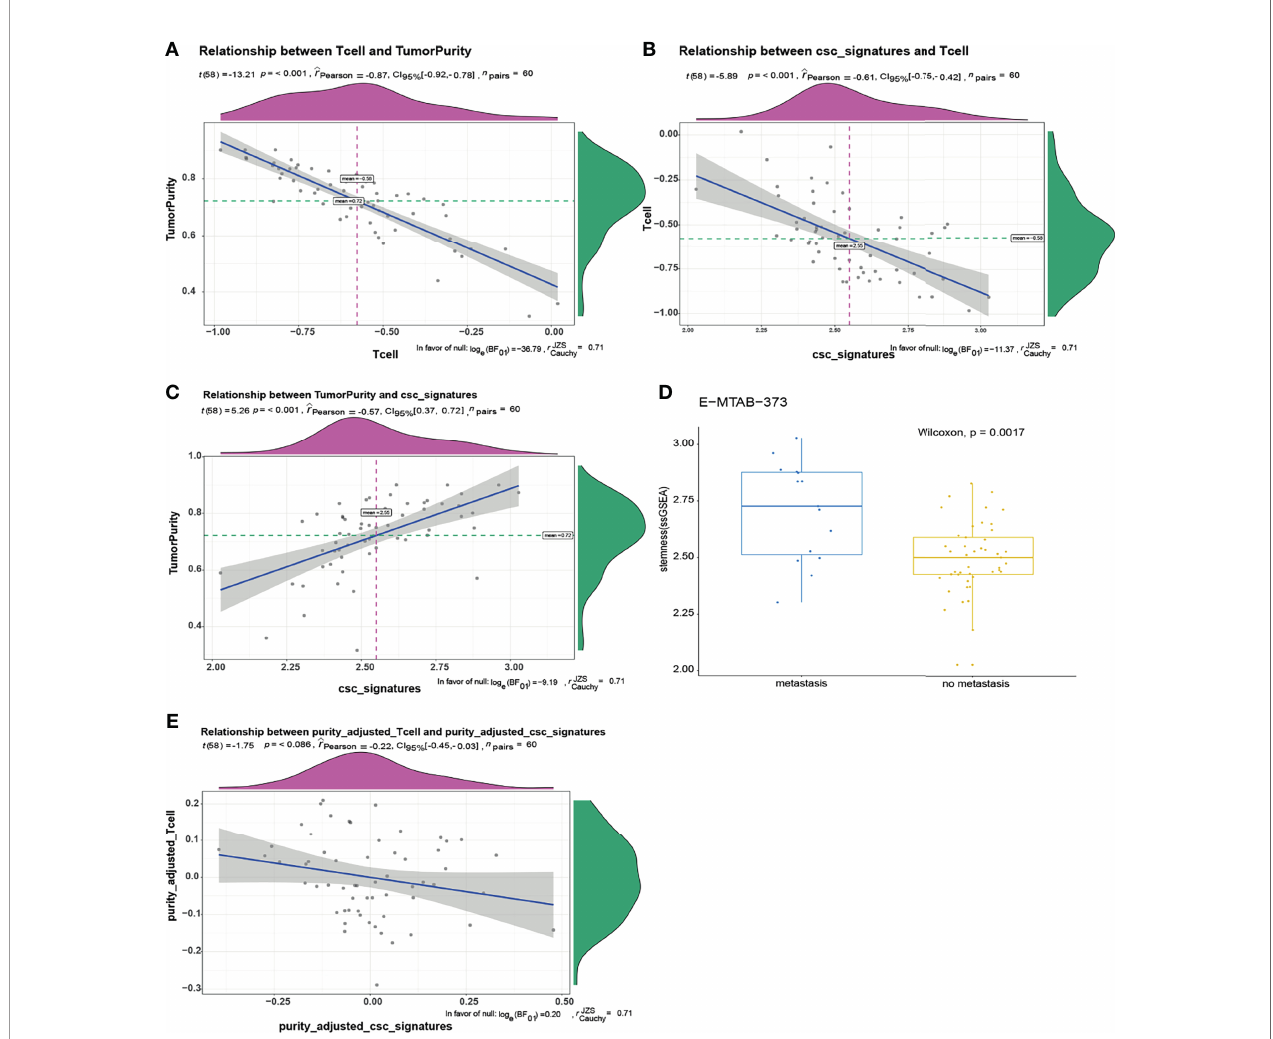
FIGURE 3 | There was a negative correlation between T-cell in fi ltration and stemness index in GIST, and the relationship depends on tumor purity. (A) There was a negative correlation between tumor purity and T-cell in fi ltration, the correlation coef fi cient was -0.87, p < 0.001. (B) T-cell in fi ltration was negatively correlated with cancer stemness index. The correlation coef fi cient was -0.61, p < 0.00. (C) There was a positive correlation between tumor purity and cancer stemness index. The correlation coef fi cient was 0.57, p < 0.001. (D) The cancer stemness index of tumor metastasis group was signi fi cantly higher than that of non-metastasis group (p = 0.0017). (E) After adjusting for tumor purity, there was no signi fi cant correlation between T-cell in fi ltration and cancer stemness